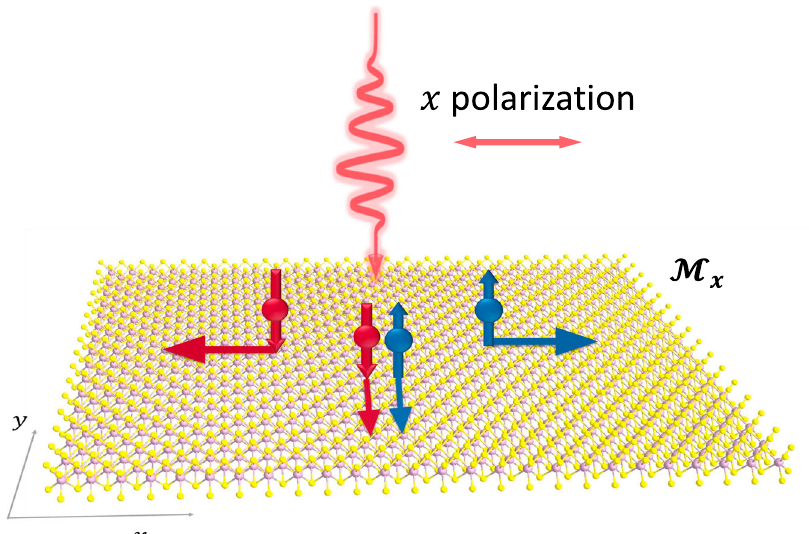
Fig. 1 A schematic illustration of pure spin and charge current. The light polarizes in the x -direction, while the system has mirror symmetry M x . In the x- direction, spin-up and spin-down states travel in opposite directions, so that the net charge current is vanishing, whereas the net spin current goes to the + x -direction. In the y -direction, spin-up and spin-down electrons travel in the same direction, leading to nonvanishing charge current but vanishing spin